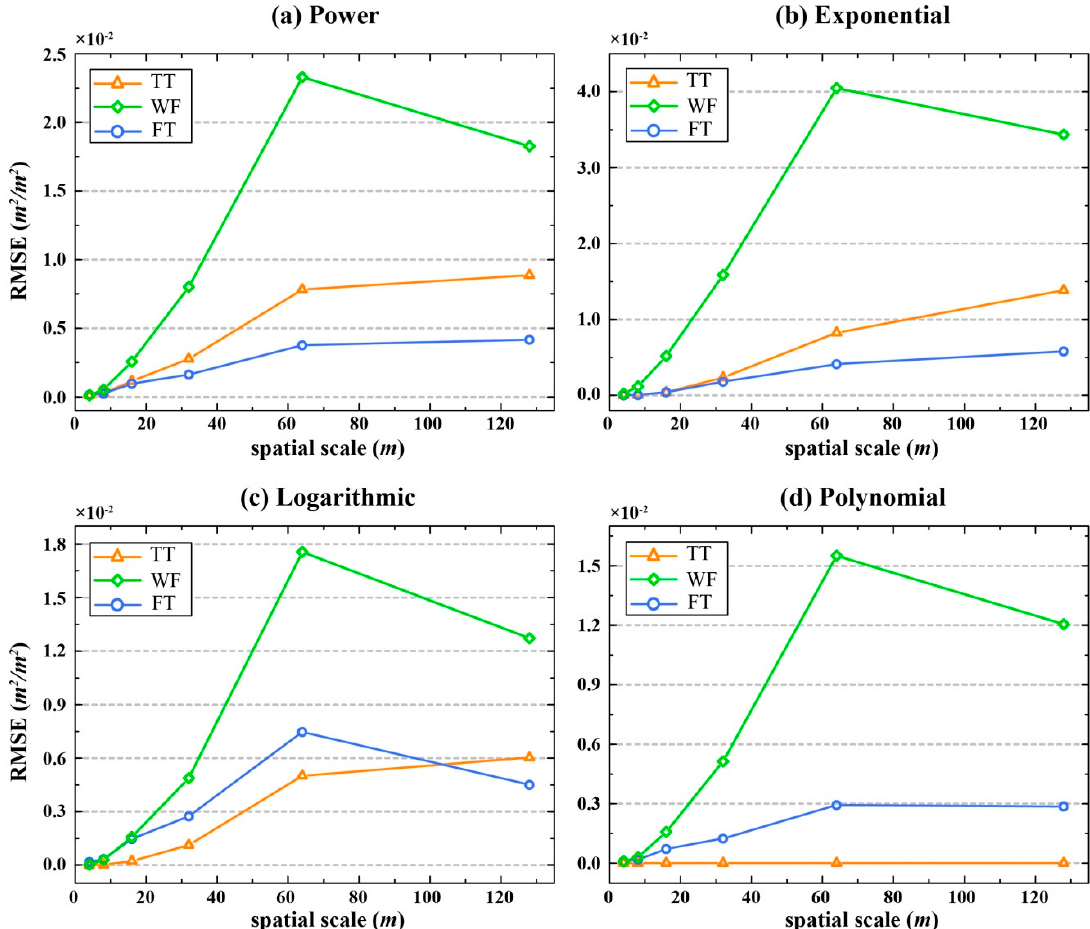
Figure 10. Correction of scaling bias with the four LAI estimation models at different spatial resolutions using the three techniques. The LAI estimation models are: ( a ) power model; ( b ) exponential model; ( c ) logarithmic model; and ( d ) polynomial model. The three techniques used to correct scaling bias are: TT (Taylor’s theorem), WF (Wavelet-Fractal technique), and FT (Fractal theory). The spatial scales are: 4 m, 8 m, 16 m, 32 m, 64 m, and 128 m.